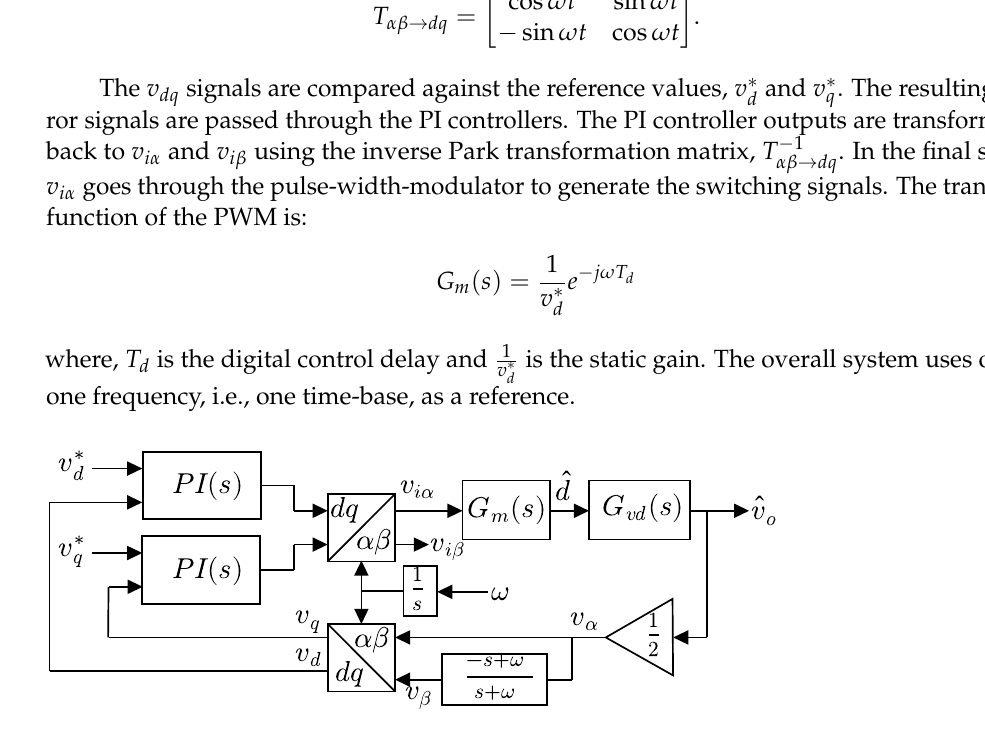
Figure 15. Boost inverter voltage mode controller block diagram.